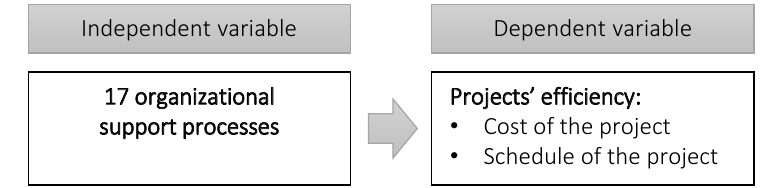
Figure 1. Research